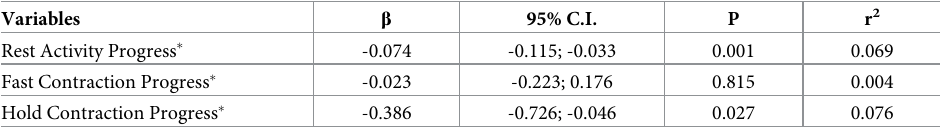
Table 4. Quantile regression of PFM recruitment progress from 24–30 to 36–38 weeks gestation during rest-activ- ity, fast and hold contractions.